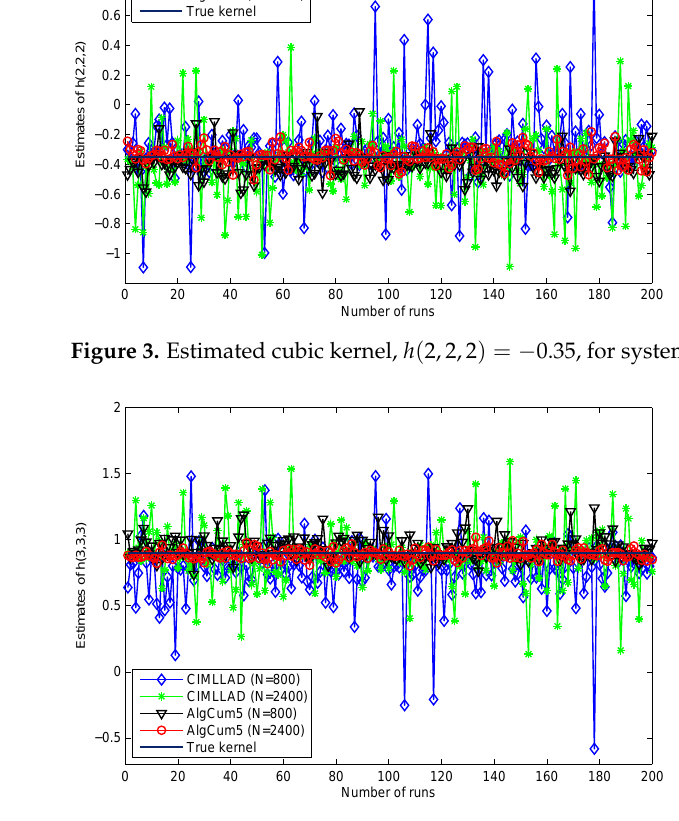
Figure 4. Estimated cubic kernel, h ( 3,3,3 ) = 0.90, for system I.